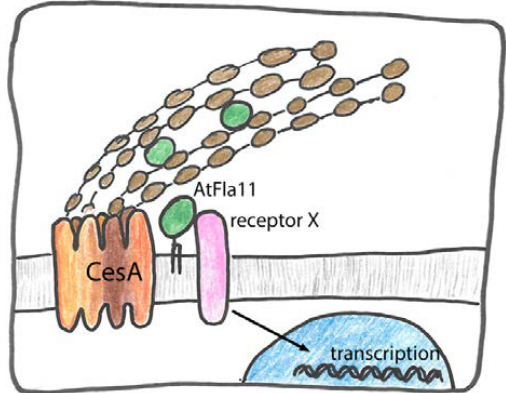
Figure 6. Putative role of AtFla11 , AtFla12 and their orthologs in secondary cell wall formation. Firstly they might act as secreted structural proteins in secondary cell walls binding to cellulose or other glycans. Secondly, they might be part of outside–in signaling, in connection with an unknown receptor that leads to complex changes of gene expression. Thirdly, they might bind to cellulose synthase (CesA) and directly influence or stabilize its action. Finally, they might act as adaptors between CesA and receptor kinases to modulate CesA phosphorylation. The FAS1 proteins encoded by the AtFla3 and the OsMtr1 genes, respectively, are required for male gametophyte development; however, the mRNA pattern in Arabidopsis thaliana suggests that several FLAs might sequentially act in this process (Figure 7).